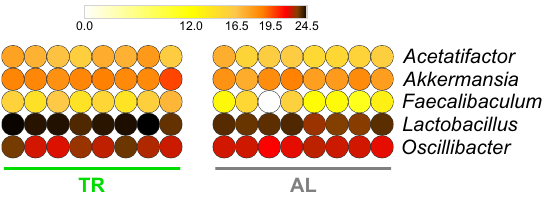
Fig. 3 Changes in taxonomic genus composition in the fecal metaproteome of TR- vs. AL-fed rats. Heatmap illustrating microbial genera with signi fi cantly differential abundance between AL and TR groups (FDR < 0.1). Each dot indicates a different sample. The color gradient is based on the relative abundance of the